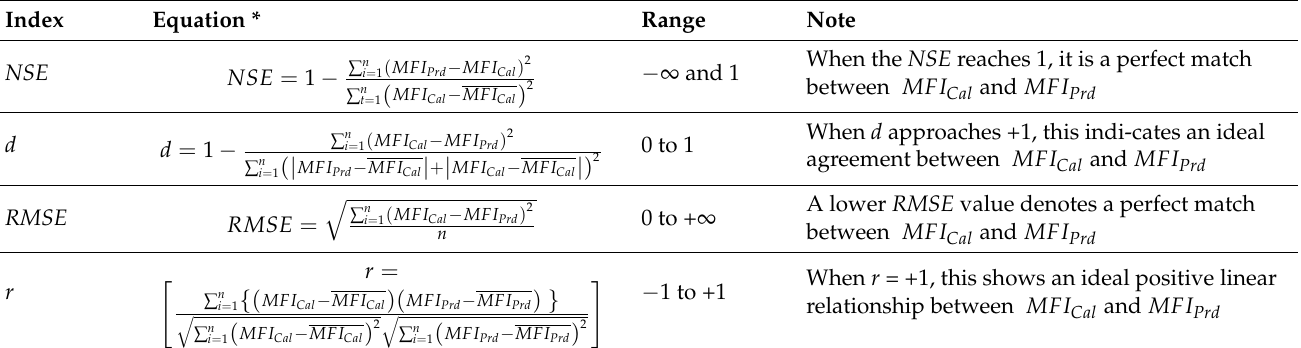
Table 6. Indices for evaluation of ANN performance for predicting MFI